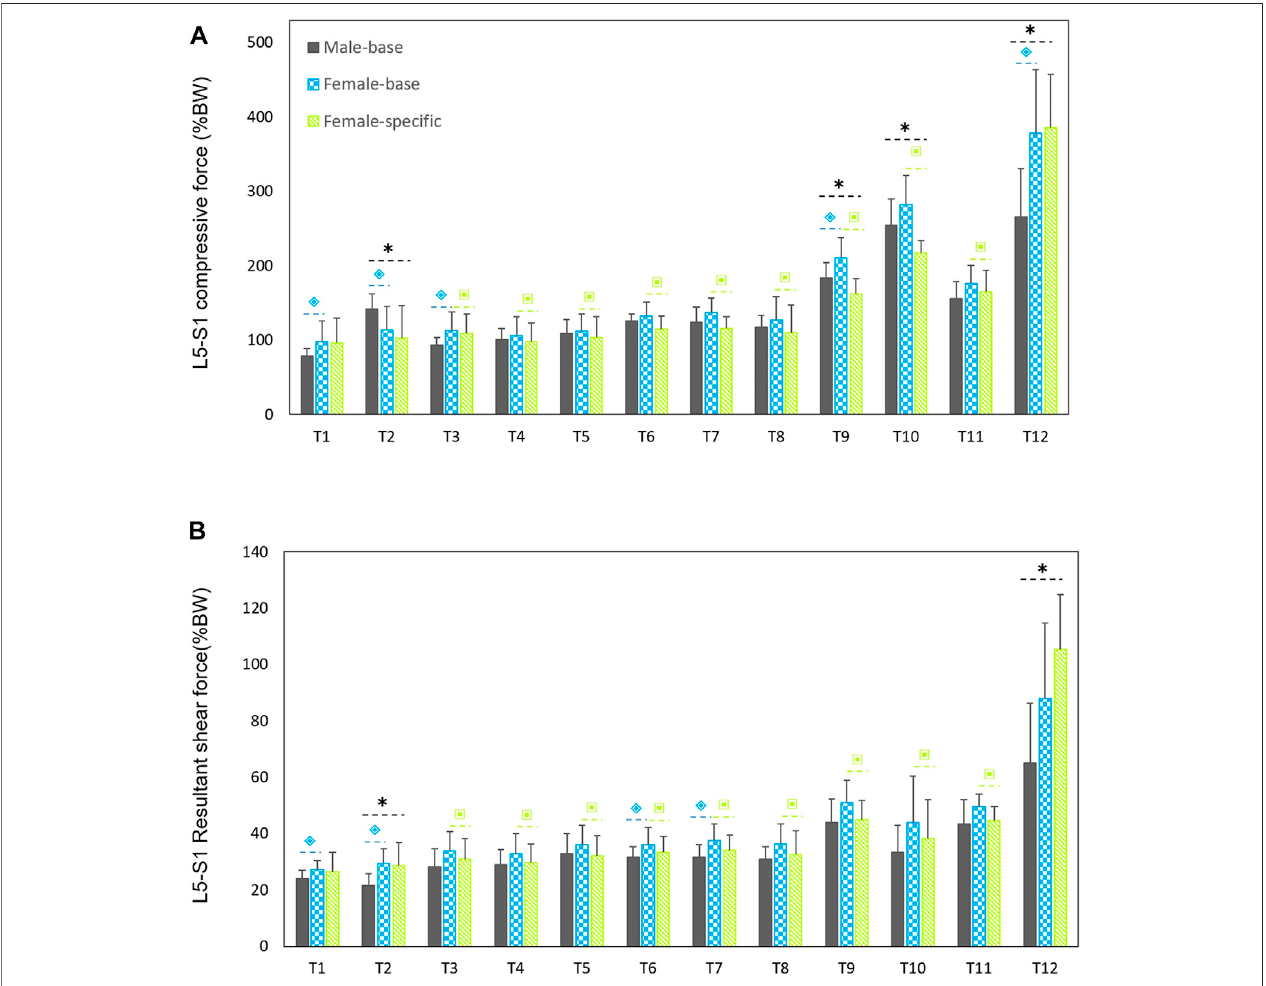
FIGURE4| Predictedmean(standarddeviationsaserrorbars)L5-S1compressive (A) andshear (B) forcesnormalizedtobodyweight(%BW)bythebase-models for both sexes and female-speci fi c models for females. ⌺ indicates a signi fi cant difference ( p < 0.05) between males and females load predicted by base-models. * indicates a signi fi cant difference ( p < 0.05) between loads predicted by male models and female-speci fi c models. ⌺ indicates a signi fi cant difference ( p < 0.05) between loads predicted by female-base models and female-speci fi c models.